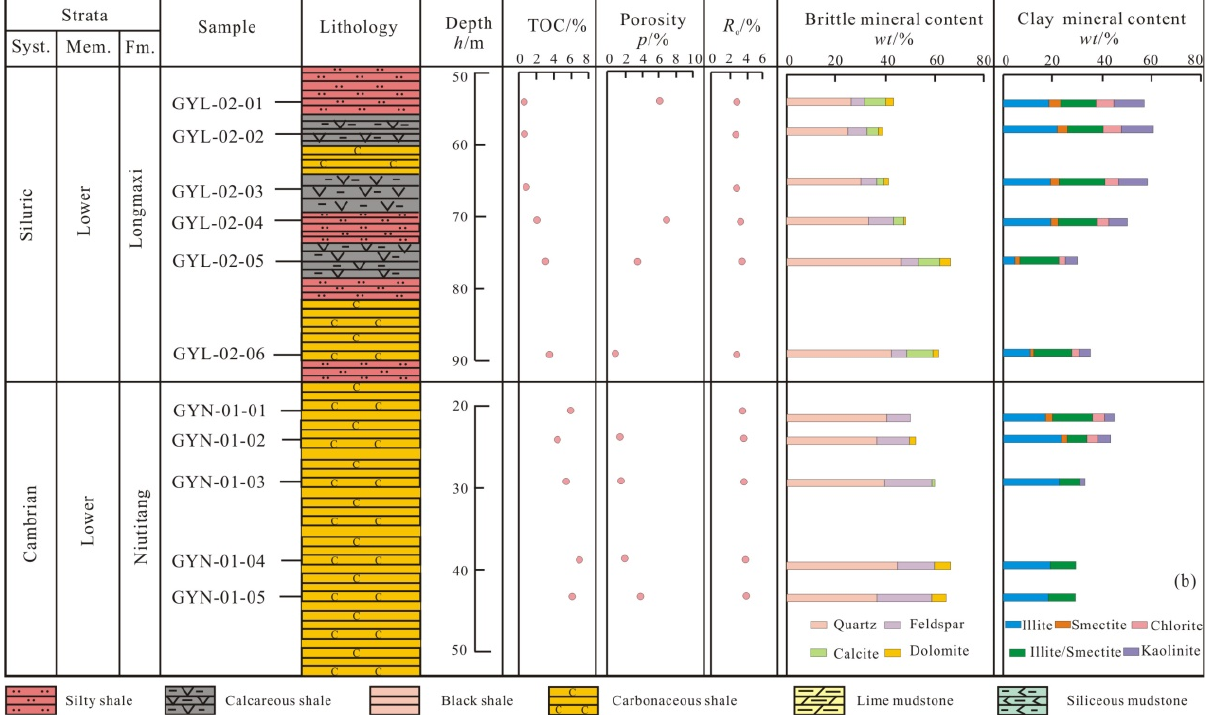
Figure 2. Geochemical characteristics of the Lower Paleozoic shale from southern Sichuan Basin ( a ) and northern Guizhou province ( b ).